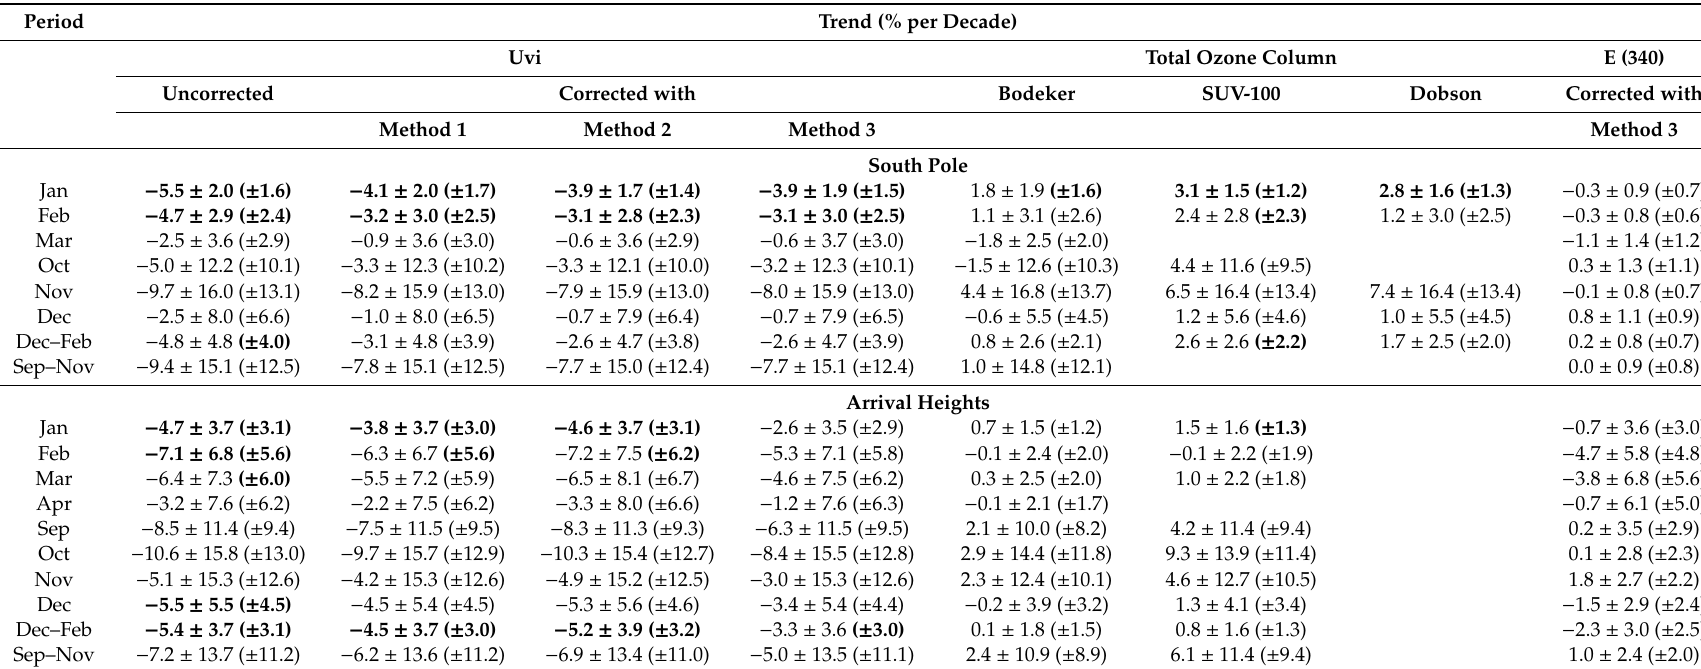
Table 2. Trends in UVI, TOC, and E(340) at the South Pole and Arrival Heights in percent per decade. The first value after “ ± ” indicates the uncertainty at the 95% level of confidence. The value in parenthesis is the uncertainty at the 90% level. Trends that are statistically significant at the 95% level are indicated in bold face. For trends that are significant at the 90% level, only the uncertainty provided in parenthesis is printed in bold